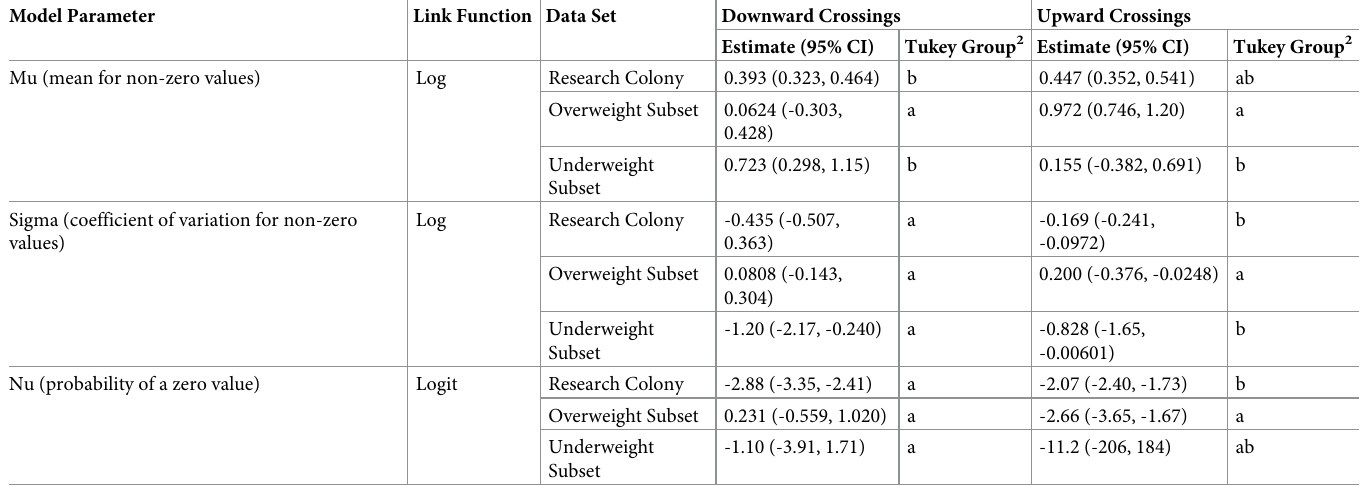
Table 2. Comparison of upward and downward crossings in the three comparison datasets.